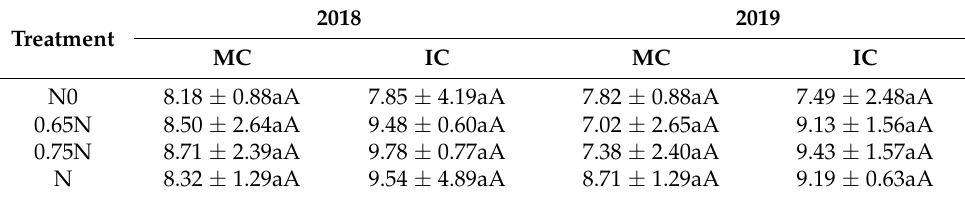
Table 6. Effects of different treatments on soil-available phosphorus content (mg kg − 1 ). Treatment